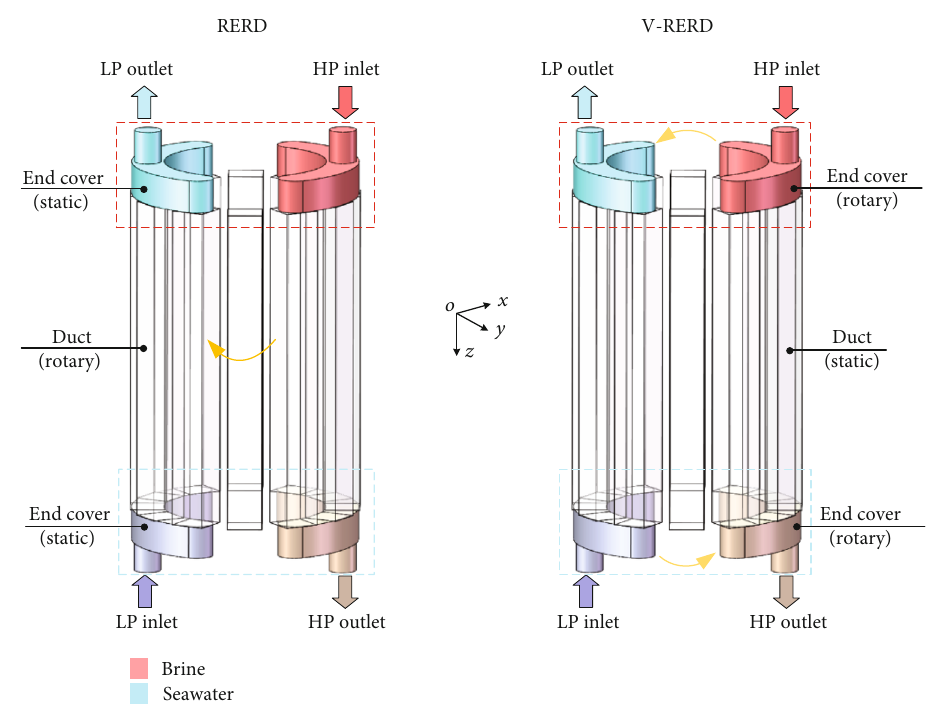
Figure 3: Schematic views of RERD and V-RERD.